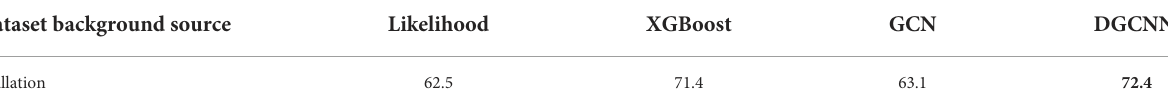
TABLE 4 Overall accuracies for neutron capture vs. electron background classification for the likelihood analysis (Likelihood), XGBoost, GCN, and DGCNN methods.